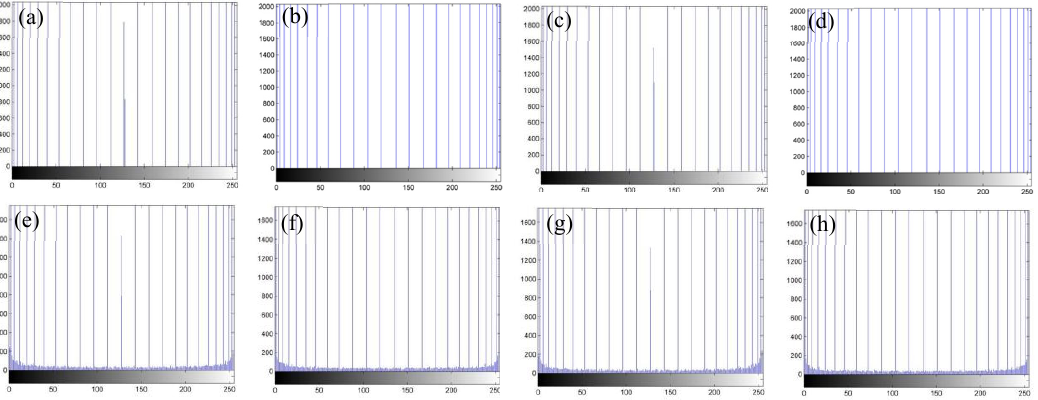
Figure 9. The histograms of the eight original images. ( a – h ) The histogram distributions of the original images.